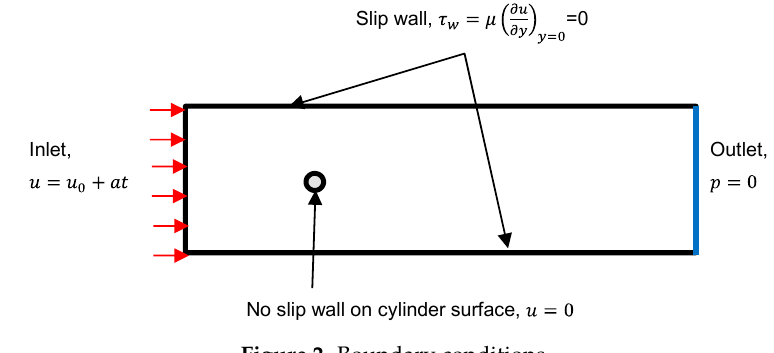
Figure 2. Boundary Figure 2. Boundary conditions Figure 2. Boundary conditions